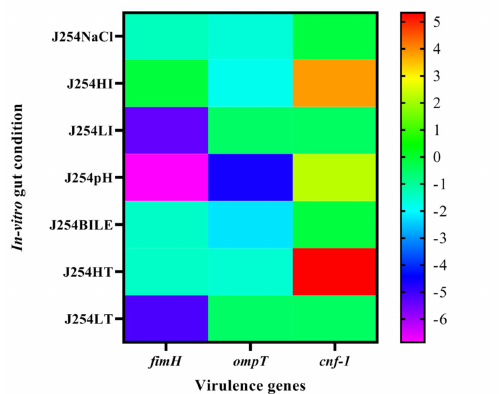
Figure 4. The expression level of virulence genes on exposure to in vitro gut conditions in J254 are presented using fold change values transformed to log2 format. The color scale indicating log2 (fold ‐ change values) is shown towards the right of the heat map.